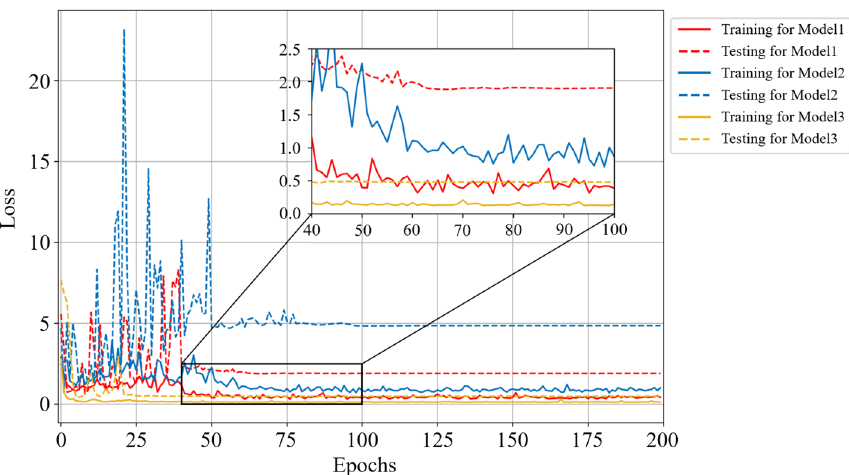
Figure 10. Comparison curves of loss performance of different models on simulated site